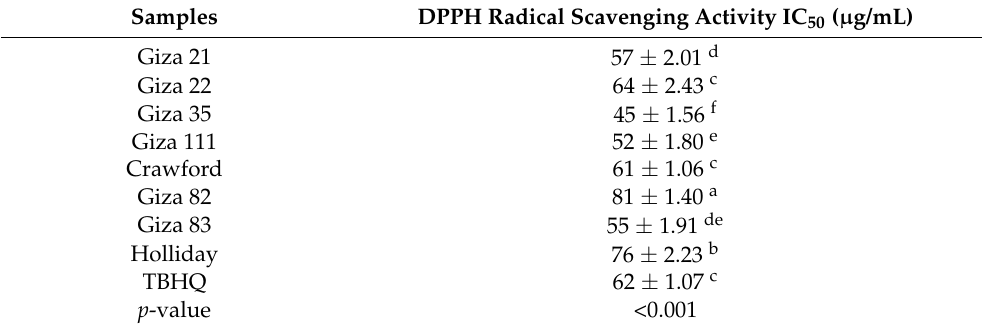
Table 4. DPPH radical scavenging activity IC 50 (µg/mL) of soybean cultivar methanolic extracts. Samples